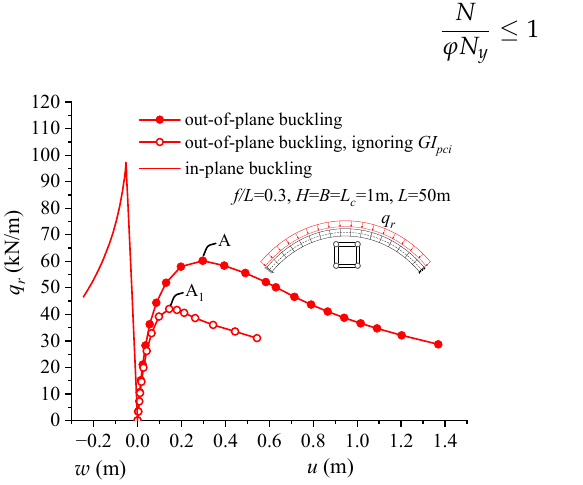
Figure 12. In-plane and out-of-plane vault displacements of a typical end-fixed Vierendeel truss arch under FSURLs.